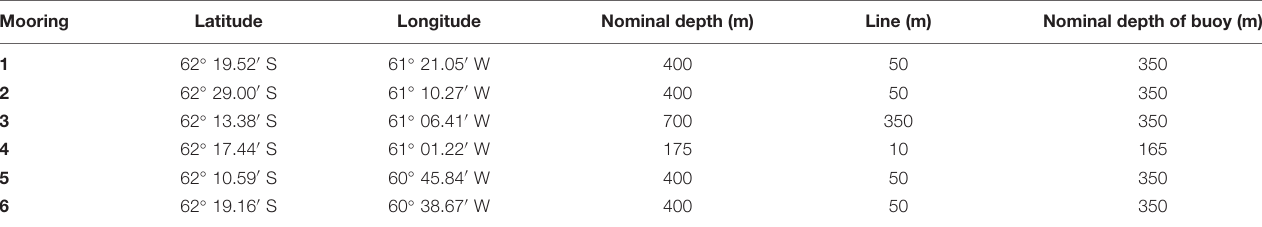
FIGURE 1 | (A) Map of study area showing the six mooring locations north of the eastern tip of the Antarctic Peninsula off Cape Shirreff (CS), Livingston Island, and bathymetric contours to a depth of 1000 m; and (B) diagram of a mooring depicting depth below surface z mb , and beams from the echosounder (es) and acoustic Doppler current profiler (adcp). TABLE 1 | Location, water depth, and buoy depths for U.S. AMLR moorings deployed during the Antarctic summer